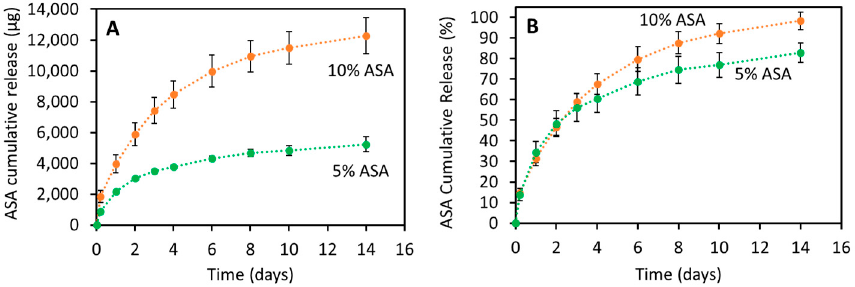
Figure 5. ASA cumulative release from 3D-printed tubular grafts: μ g of ASA ( A ) and % of the total ASA cargo ( B ) released as a function of time.